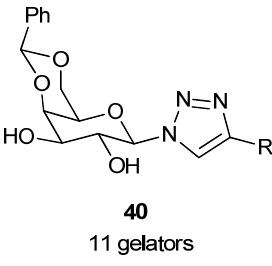
Figure 29. 4,6- O -Benzylidene- β - D -galactopyranosyl triazoles. 1,2,5,6-Di- O -isopropylidene mannitol ( 3b , Figure 2) was reported earlier by Sureshan